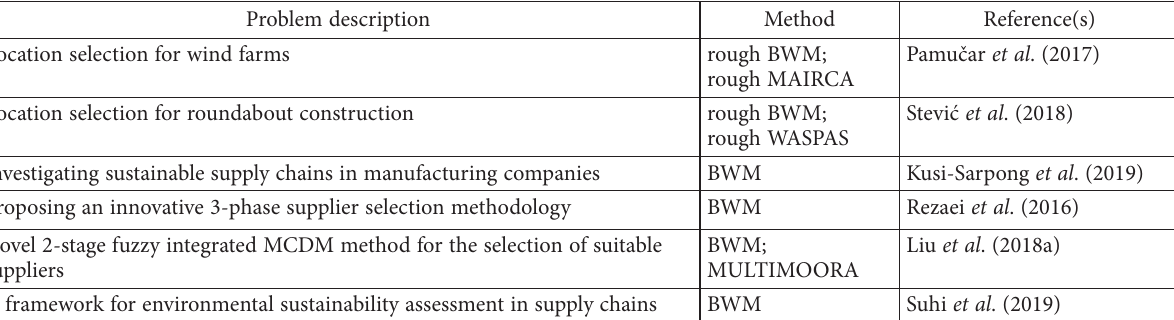
Figure 1. Main steps of this study Table 2. Sustainability assessment using BWM in